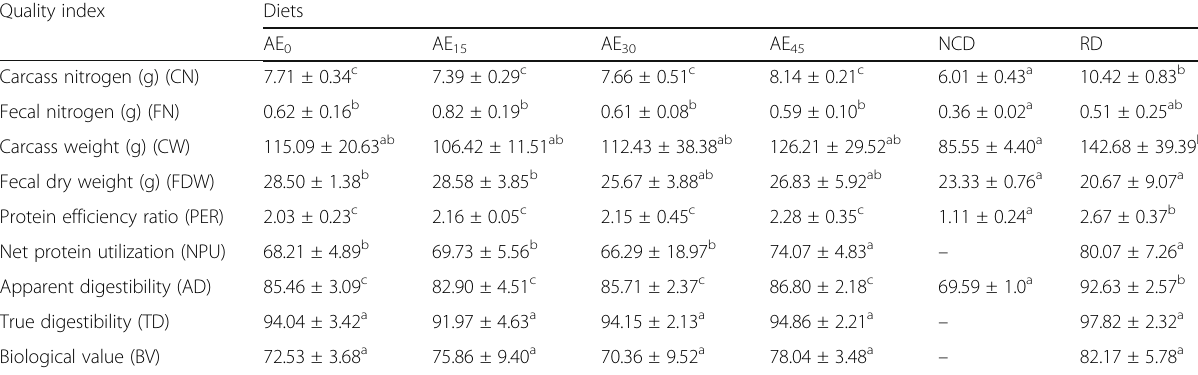
Table 4 In vivo protein quality indices of raw and macerated African elemi pulp-based diets fed to rats Quality